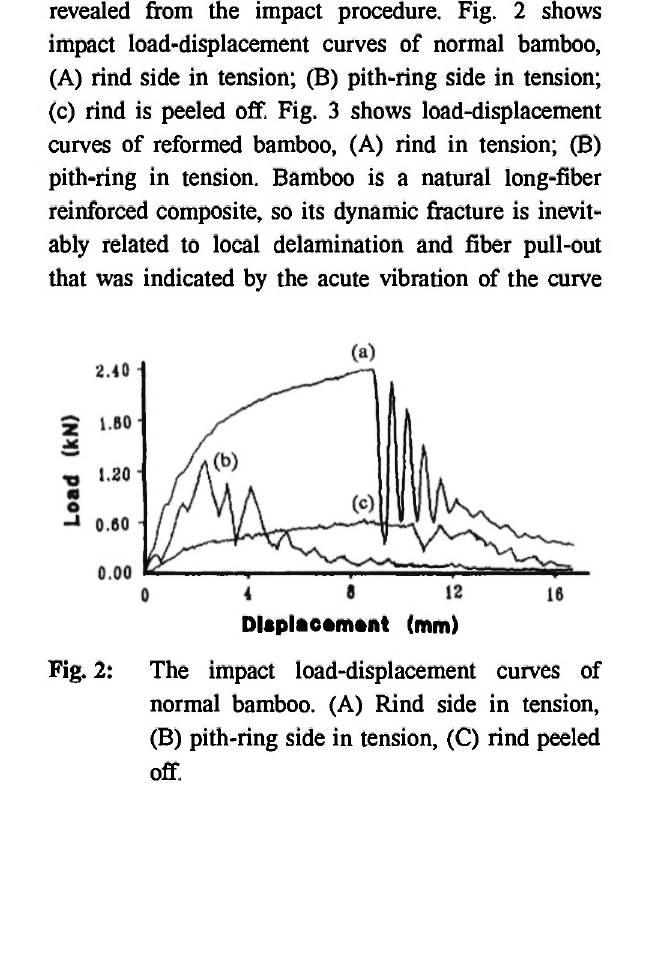
Fig. 3: The impact load-displacement curves of reformed bamboo. (A) Rind side in tension, (B) pith-ring side in